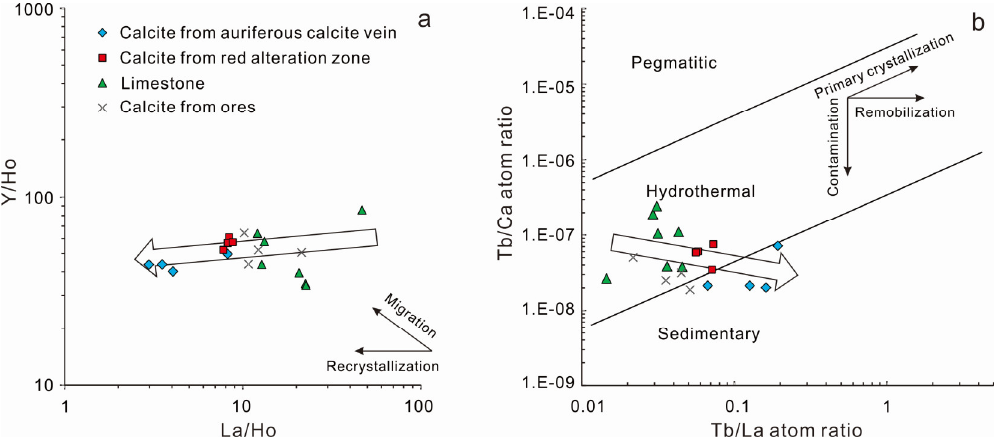
Figure 7. Plots of ( a ) Y/Ho versus La/Ho ratios and ( b ) Tb/Ca versus Tb/La ratios for the Phapon calcite and limestone. (Base maps respectively after [52,54], the grey × symbols show hydrothermal calcite from Phapon referenced from [11]).